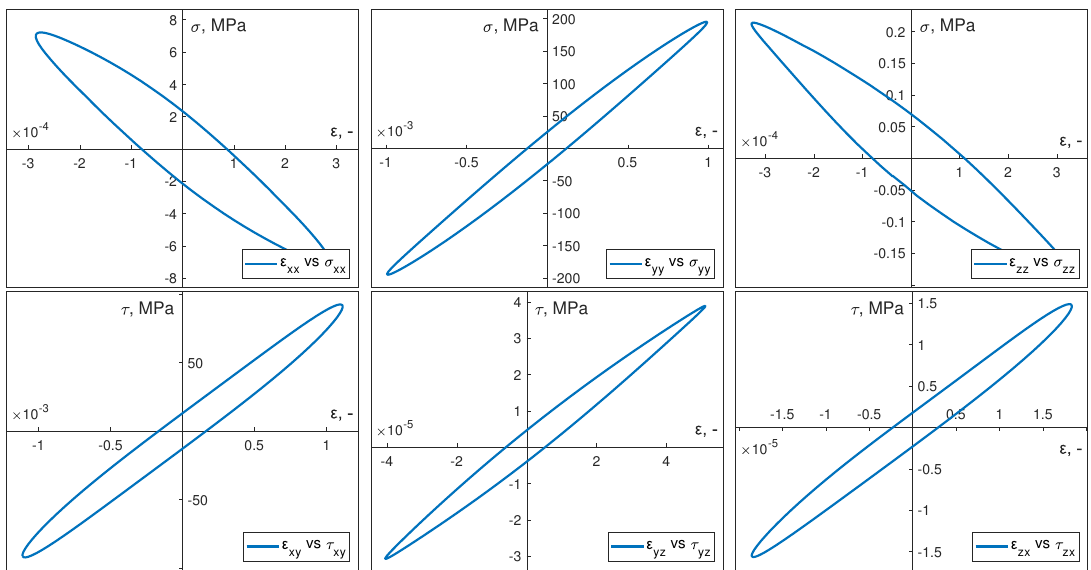
Figure 7. Numerically calculated hysteresis loops for out-of-phase dynamic